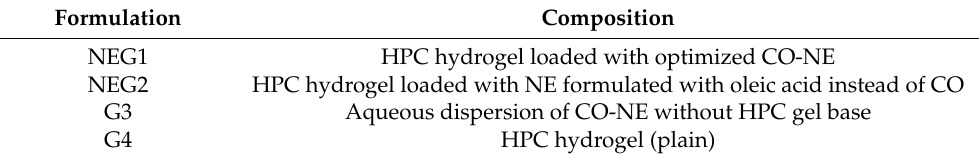
Table 2. Details of samples prepared for the characterization and evaluation of the CO-NEG. Formulation Composition NEG1 HPC hydrogel loaded with optimized CO-NE NEG2 HPC hydrogel loaded with NE formulated with oleic acid instead of CO G3 Aqueous dispersion of CO-NE without HPC gel base G4 HPC hydrogel